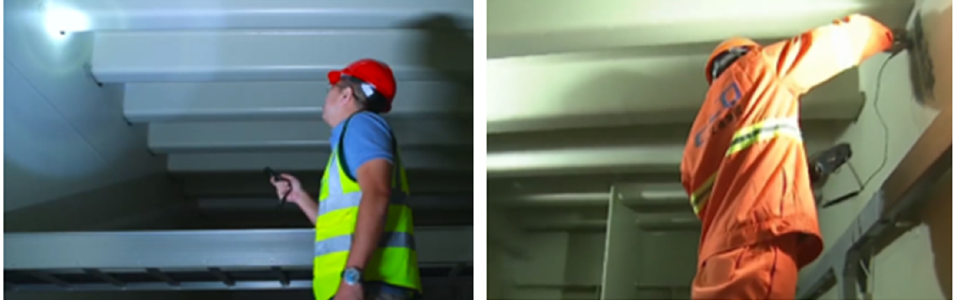
Figure 1. Manual inspection inside the SBG of a